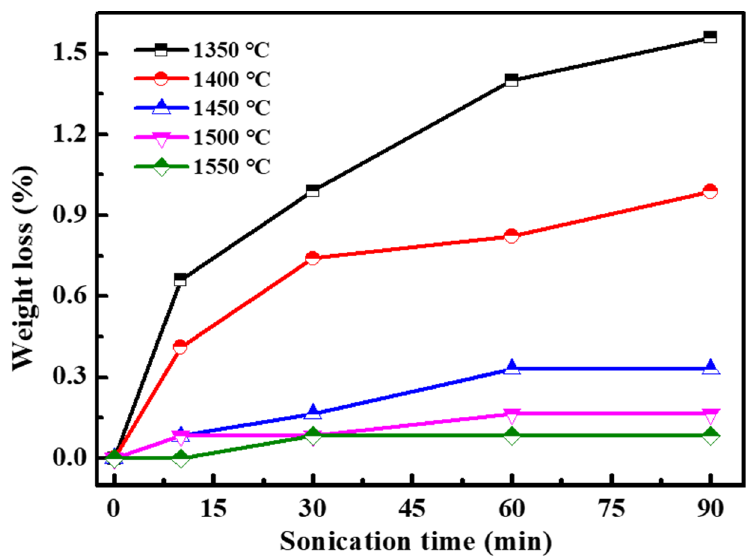
Figure 5. Weight loss of Pt/YSZ electrodes prepared at different sintering